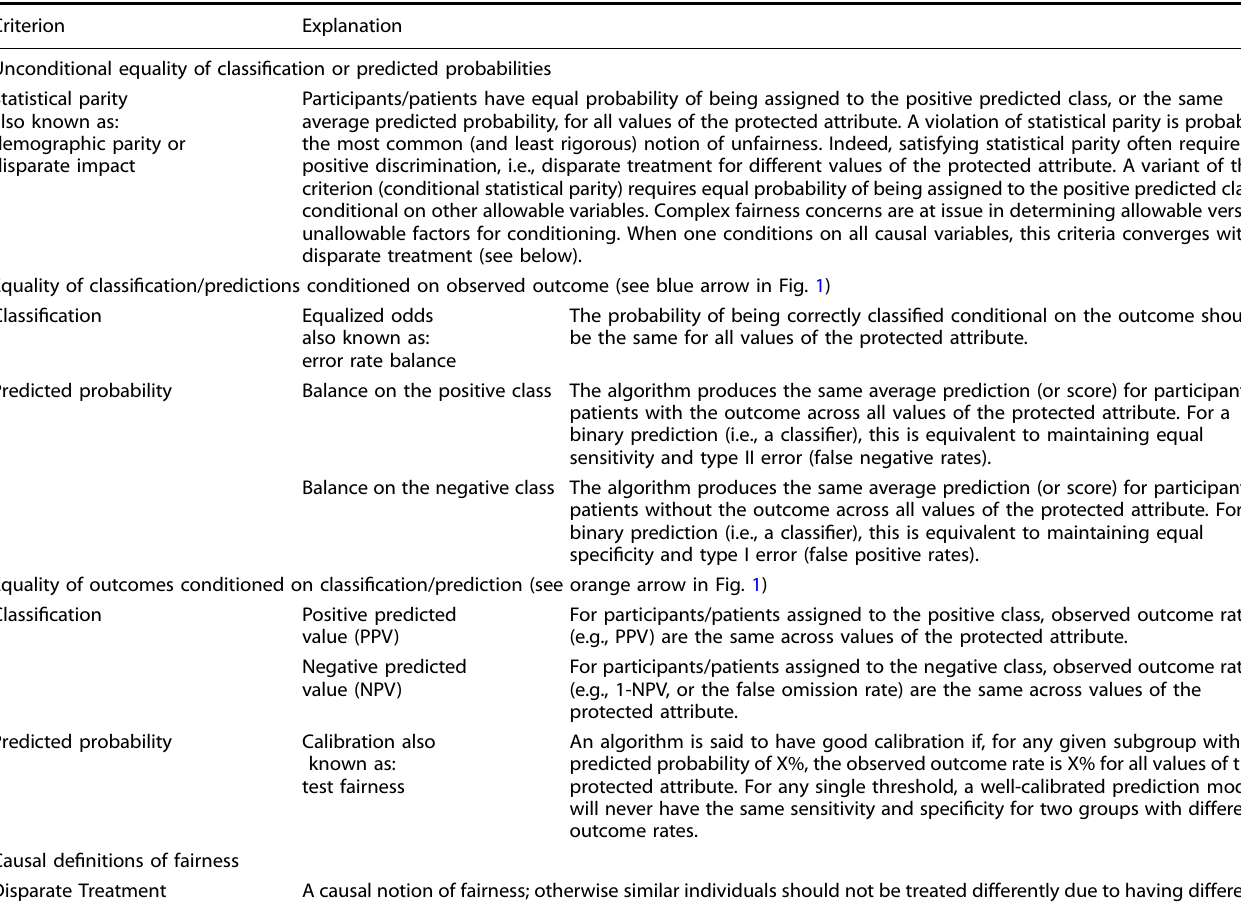
Table 1. Candidate criteria to assess algorithmic